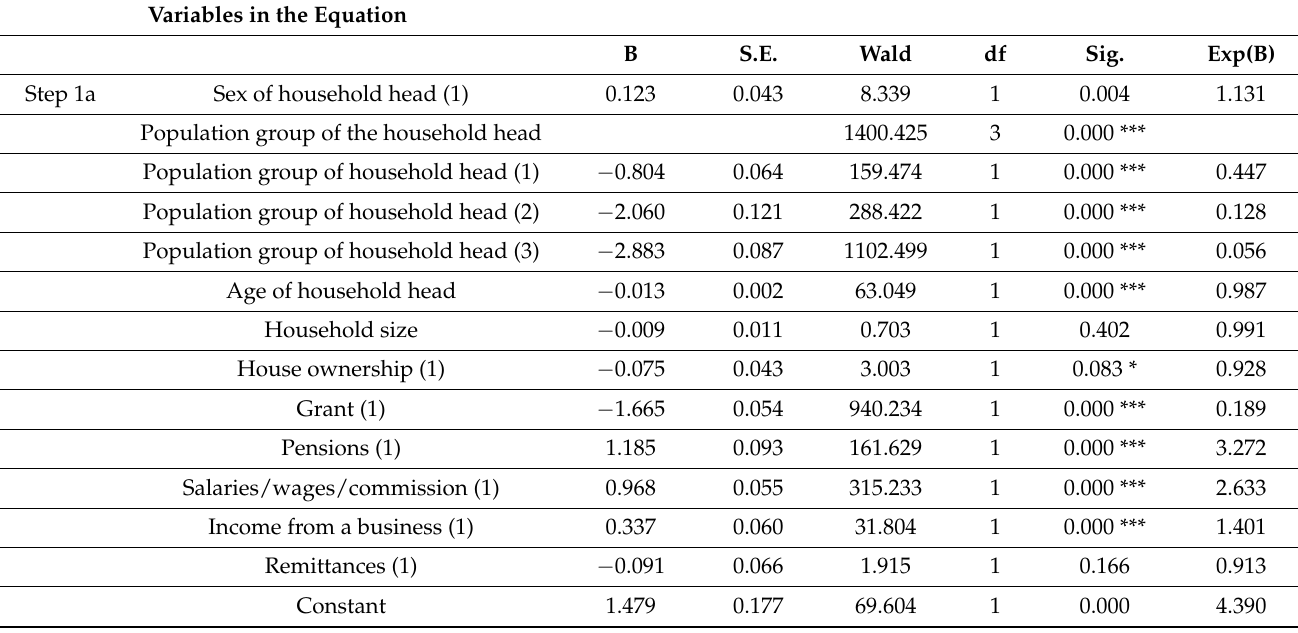
Table 2. Logit results, use of public health